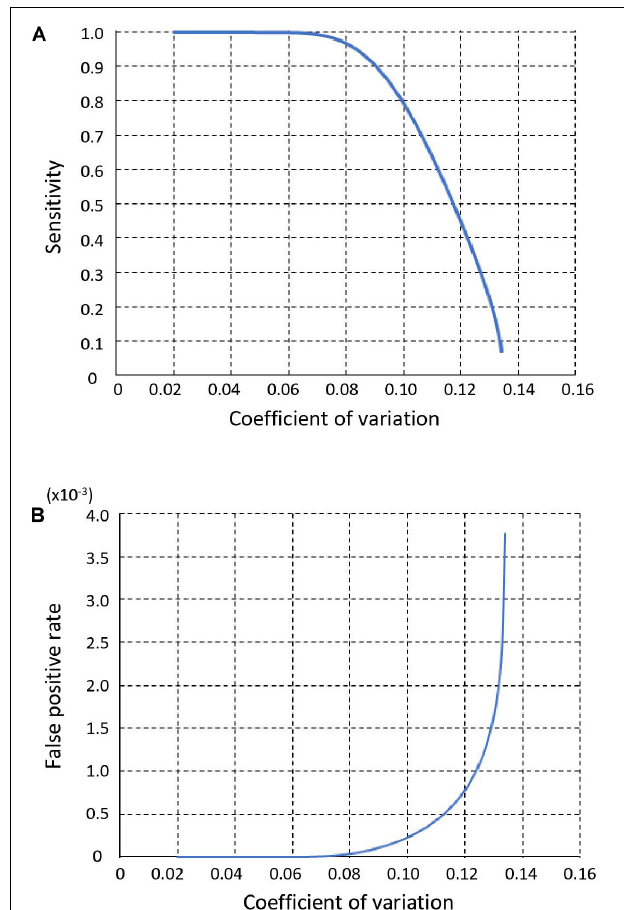
FIGURE 2 | Sensitivity (A) and False positive rate (B) of SCCNV. Y -axis value represents the coefficient of variation of the sequencing read depth (or normalized read depth) of all 500 kb bins across a single-cell genome (see section “Materials and